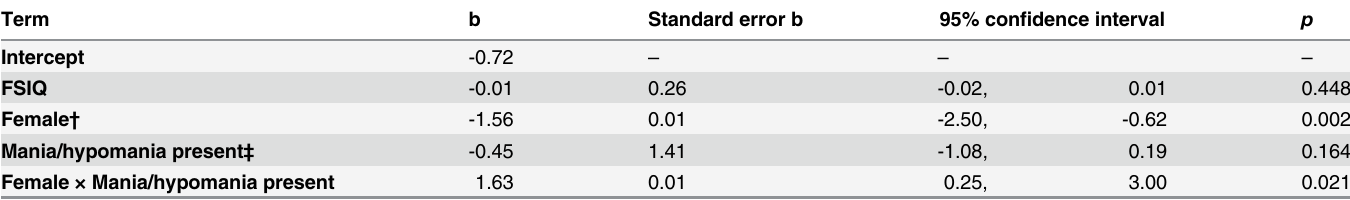
Table 4. Regression model fit to empathizing bias (EB) within the psychotic group (N = 59 given the missing values on FSIQ – see Table